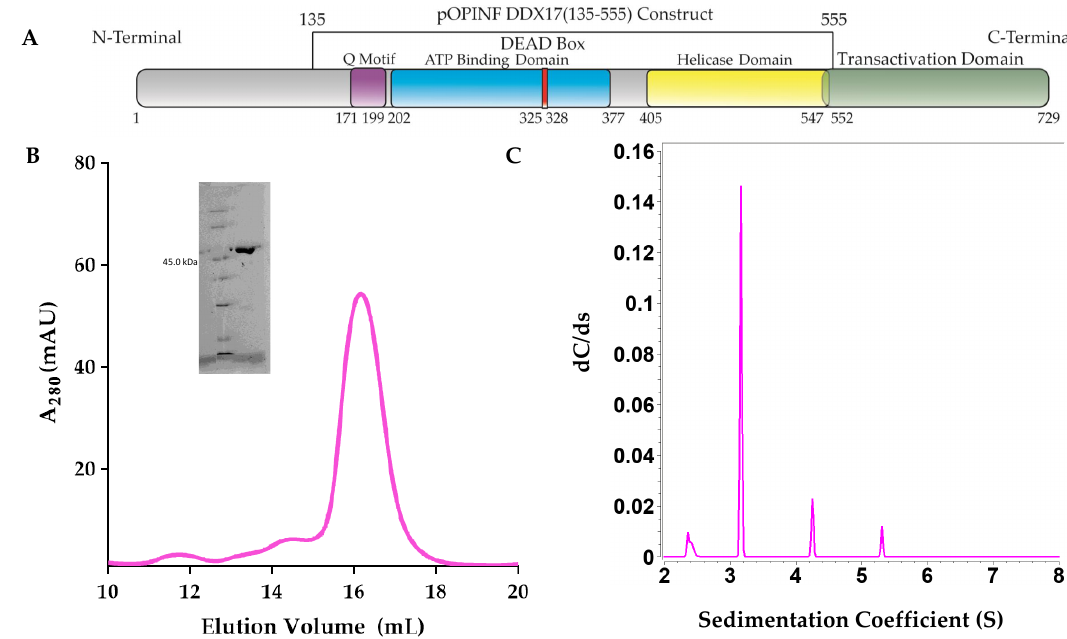
Figure 1. ( A ) Schematic representation of DDX17 highlighting individual domains. DDX17 135–555 , which contains the Q motif, ATP binding domain, DEAD-box, and the helicase domain, was used in downstream studies. ( B ) The chromatogram from the size exclusion purification (Superdex 200 Increase gl 10/300) of DDX17 135–555 , suggesting that DDX17 (135–555) can be purified to ~68% homogeneity (~16 mL). The y-axis represents absorbance at 260 nm while the x-axis represents elution volume. We collected peak fractions from 15.5 to 16.5 mL for subsequent analysis. The inset to Figure 1B represents the SDS-PAGE analysis of DDX17 135–555 (48.45 kDa) following size exclusion chromatography. ( C ) Sedimentation coefficient distribution of DDX17 135–555 obtained from analytical ultracentrifugation sedimentation velocity (SV-AUC) experiment. The peak at ~3.16S represents monodispersed DDX17 135–555 . Sedimentation coefficient values are corrected to standard solvent conditions (20 ◦ C in